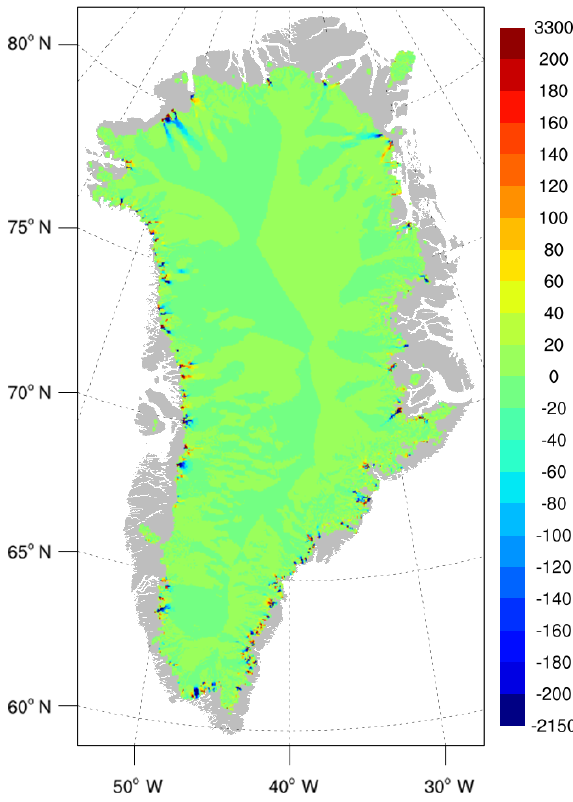
Figure 13. Difference (m) in simulated ice thickness after 10kyr between (1) a run using the BP velocity solver and (2) a run using the DIVA velocity solver and otherwise configured identically. The gray background shows regions that are ice-free in both simulations.